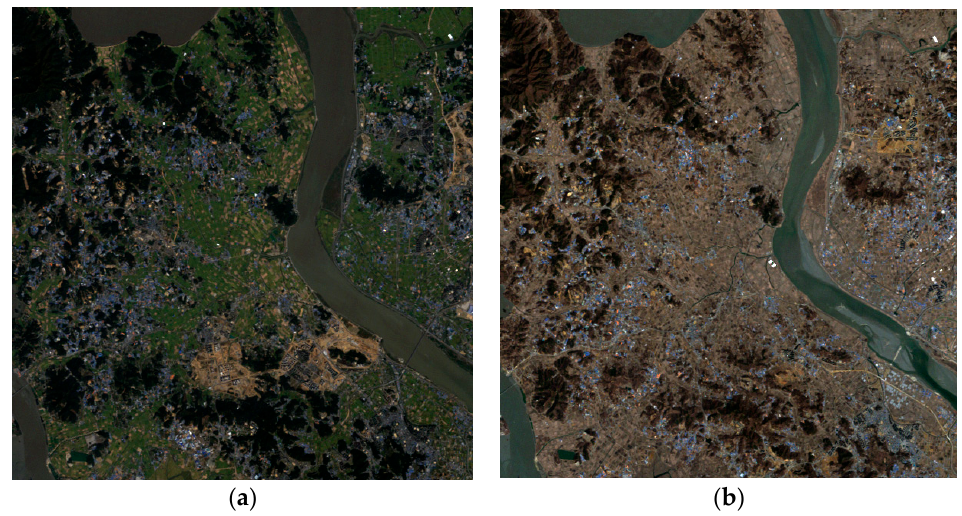
Figure 1. Study area: ( a ) subject image (27 September 2011); and ( b ) reference image (18 March 2005).